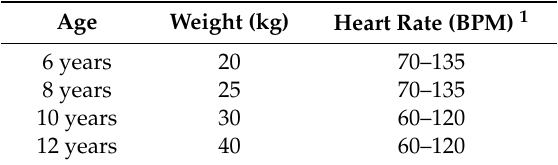
Table 1. Normative ranges of the heart rate in the pediatric